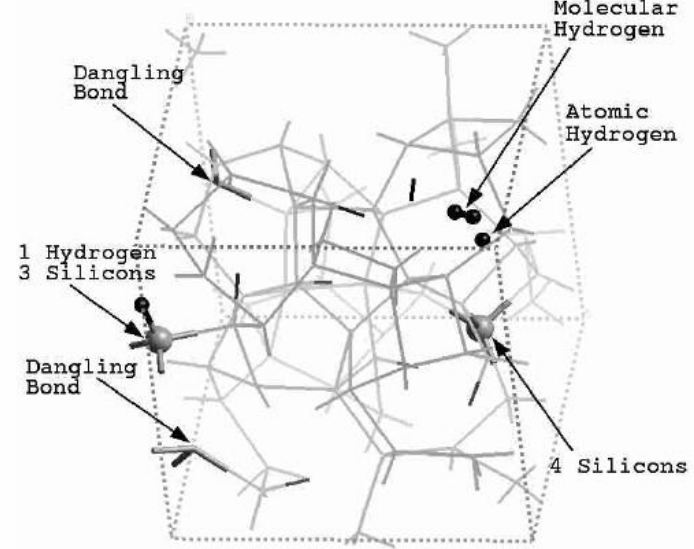
Figure 38. Hydrogen addition to the 10/2 fs cell passivates all dangling bonds (2) and 2 new ones appear plus 3 floating bonds. The molecular and atomic hydrogens are